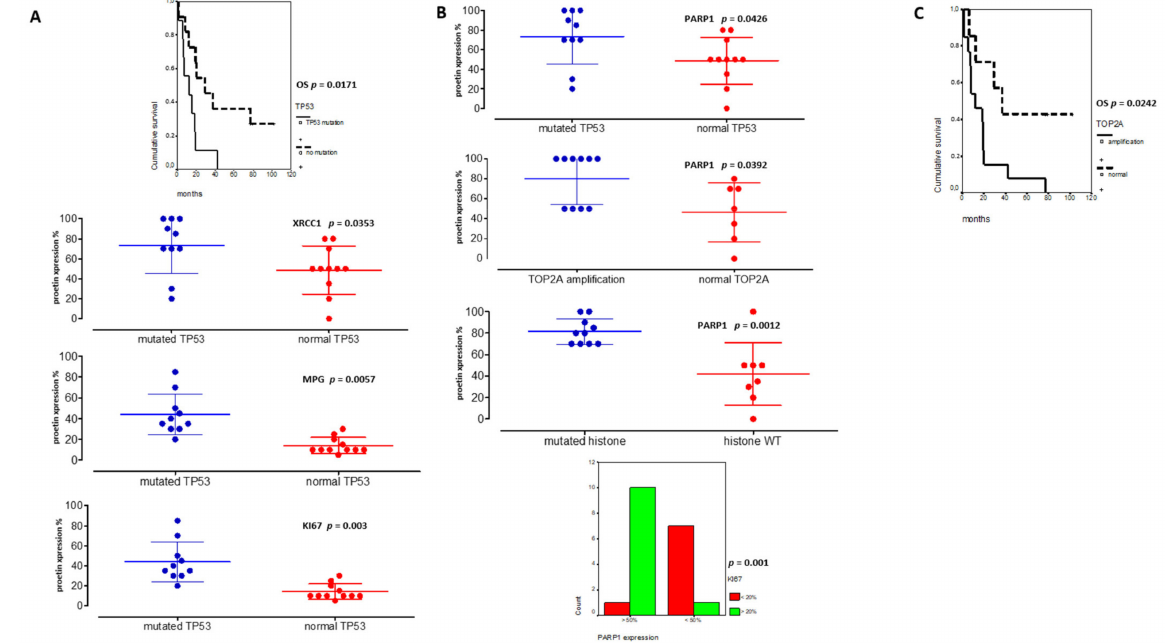
Figure 5. TP53 and PARP1 are major theranostic markers in pHGGs. ( A ) Significant associations between TP53 mutated pHGGs and DD repair protein hyper-expressions (%) (XRCC1, MPG and KI67) and their significant involvement on worst overall survival (OS). ( B ) Significant correlations between PARP1 hyper-expression and TP53 mutation, TOP2 amplification, histone mutations, and KI67 expression (above 20%). ( C ) Kaplan Meier curves reporting the significant impact of TOP2A amplification on pHGG